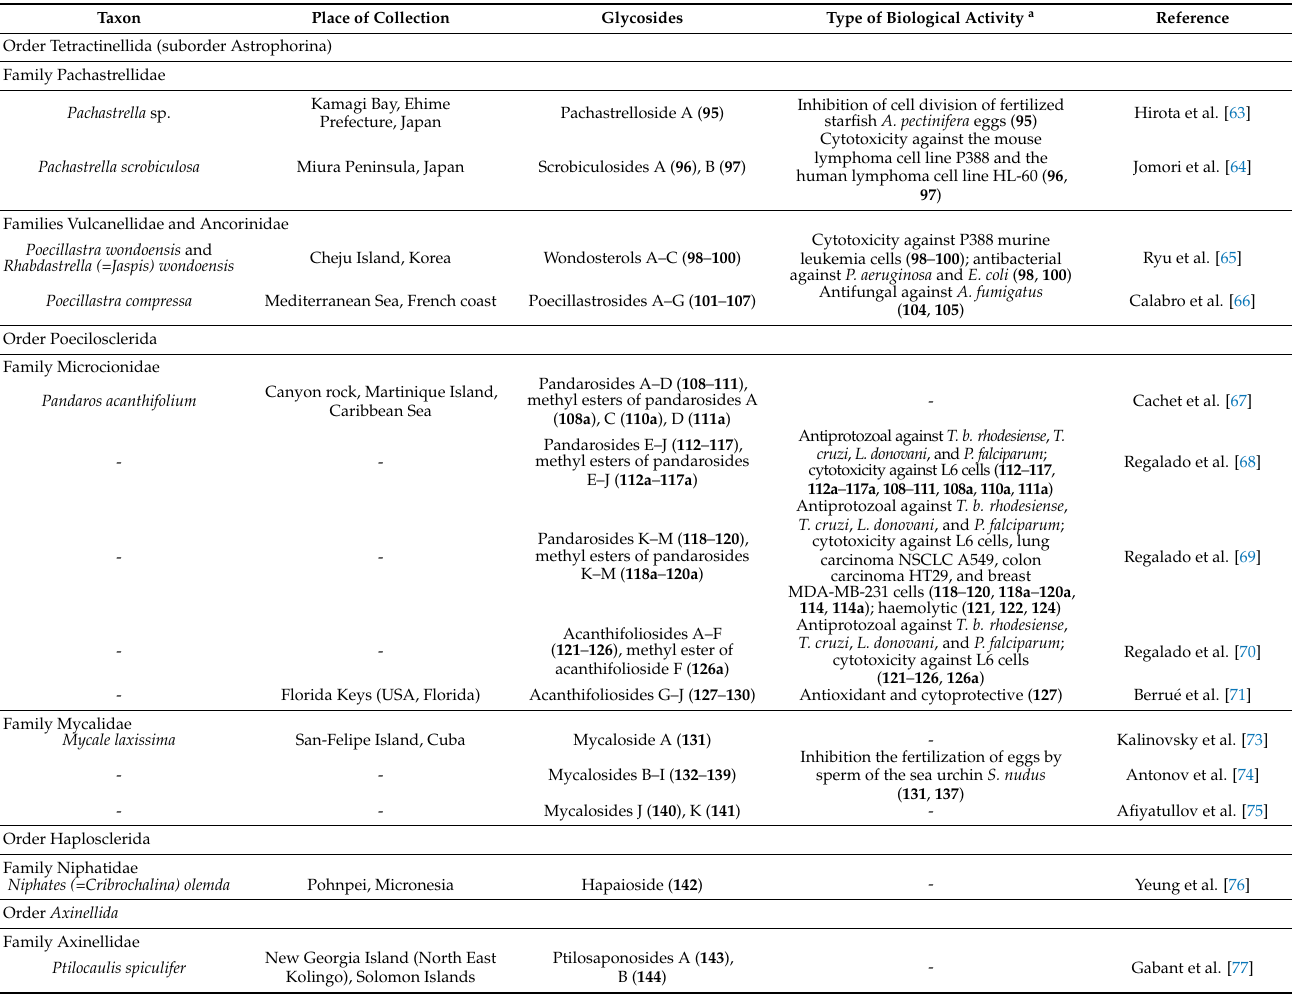
Table 2. Taxonomical distribution and biological activities of steroid glycosides in sponges of the class